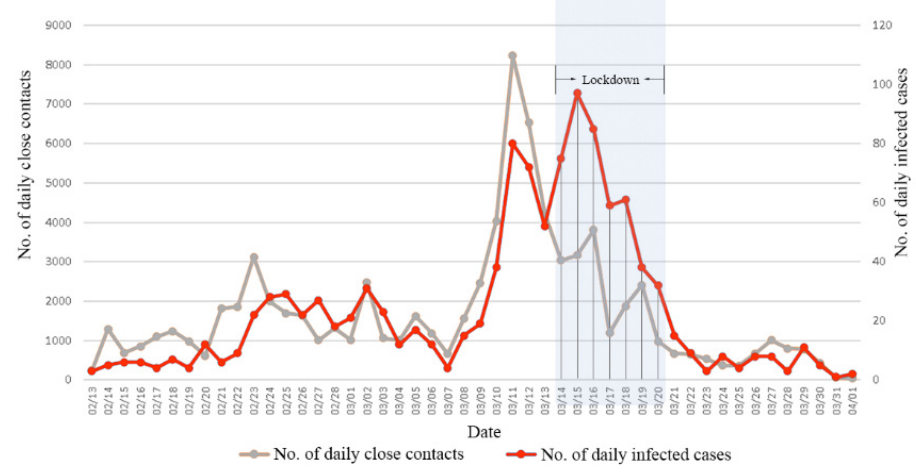
Figure 1. Ratios of the number of daily close contacts and infected cases during the Omicron epidemic in Shenzhen, China, in the spring of 2022. (Note: The grey area indicates the citywide lockdown period.) The ratio of the number of daily close contacts to the number of daily infected cases trend postimplementation of the lockdown (Figure 2). It is important to note that the ratio